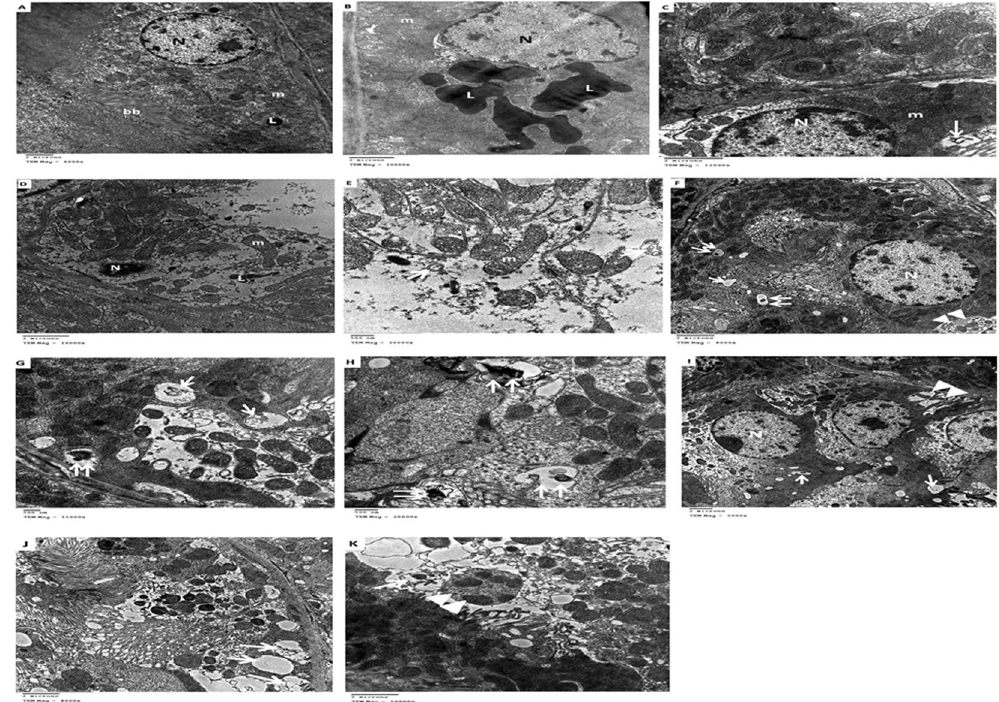
Figure 3. Transmission electron micrograph of renal tubules. ( A ) Control group: Normal structures of the nucleus, mitochondria with few scattered electron-dense lysosomes and intact bruch border were noted. ( B and C ) diabetic rats: accumulation of huge electron-dense lysosomes and few autophagic vacuoles were detected. ( D and E ) diabetic nephropathy group: apoptotic nucleus, partially degraded cytoplasm and elongated mitochondria. Also, double membrane of the autophagosome was clearly seen containing cytoplasmic debris. ( F – H ) treated diabetic rats: cytoplasm showed multiple scattered autophagosomes, autophagosomes with lysosomes (vacuoles containing electron dense material), and mitophagy (an autophagosome containing an undigested mitochondrion), indicative of autophagic activity. ( I – K ) diabetic prophylactic rats: numerous autophagosomes with degenerated membrane cellular debris and mitophagy L , lysosomes; N , nucleus; bb , bruch border; m , mitochondria; [ ↑ ], autophagosomes; [ ↑↑ ], autophagosomes with lysosomes; ▴▴ ,